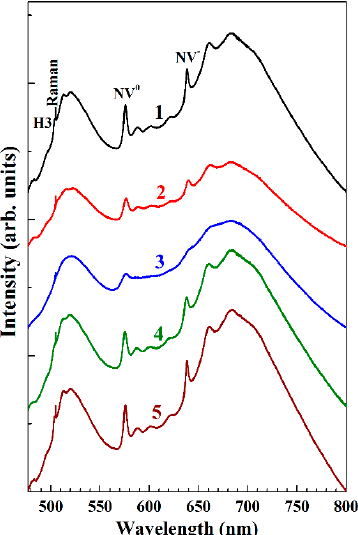
Figure 4. Photoluminescence spectra at five points ( 1 )–( 5 ) along the line A-B line crossing the top of the hillock, as shown in Figure 5a.